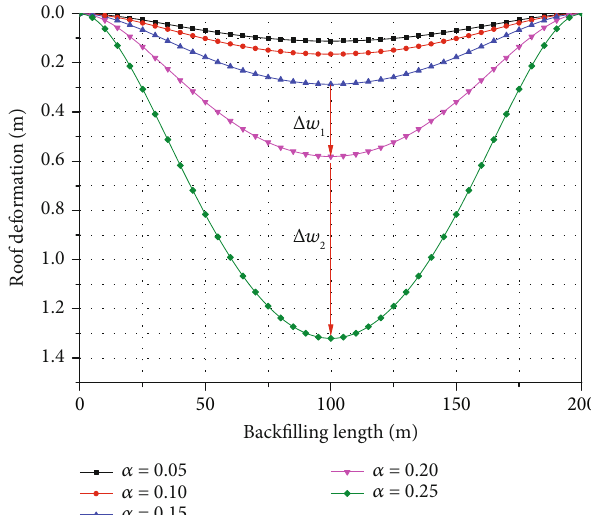
Figure 12: Roof subsidence with di ff erent fractional orders.